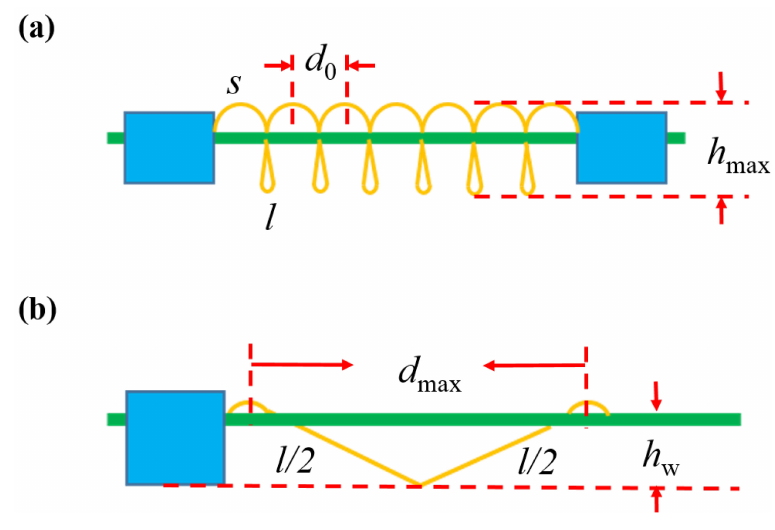
Figure 17. The initial collapsed state ( a ) and the full deployment state ( b ) of the